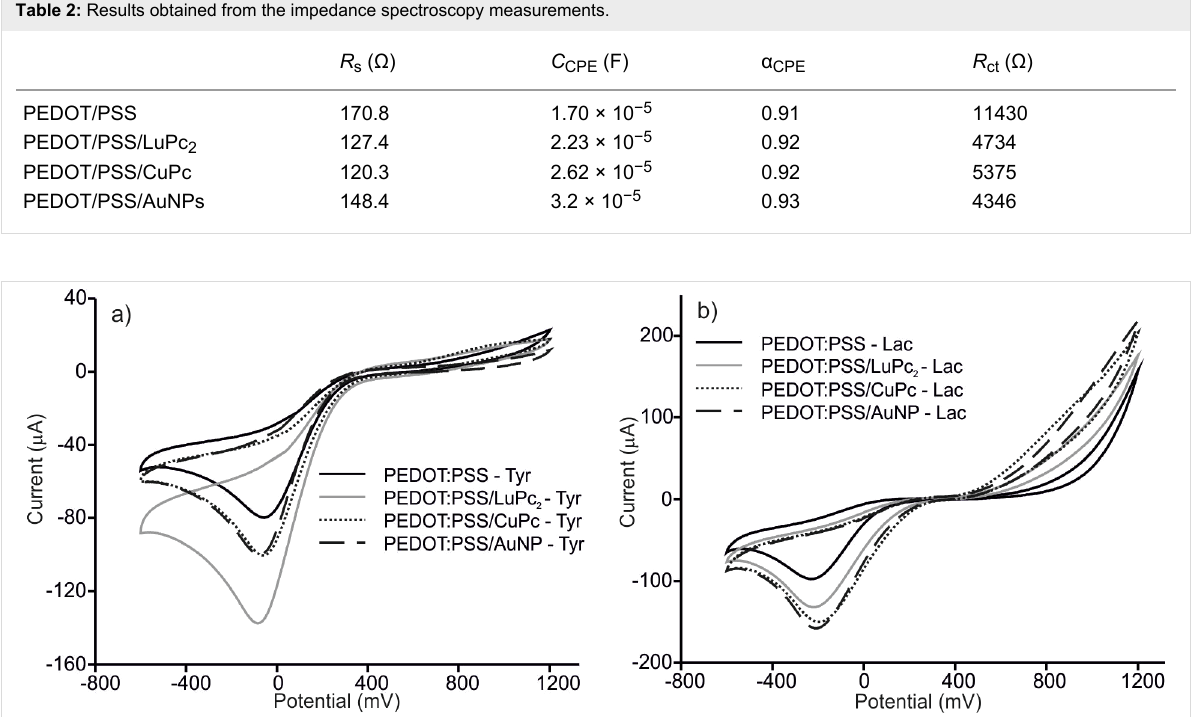
Figure 4: Cyclic voltammograms of (a) PEDOT/PSS/EM-Tyr immersed in catechol 1.5 × 10 − 4 mol·L − 1 and (b) PEDOT/PSS/EM-Lac immersed in hydroquinone 1.5 × 10 − 4 mol·L − 1 . Scan rate 0.1 V·s − 1